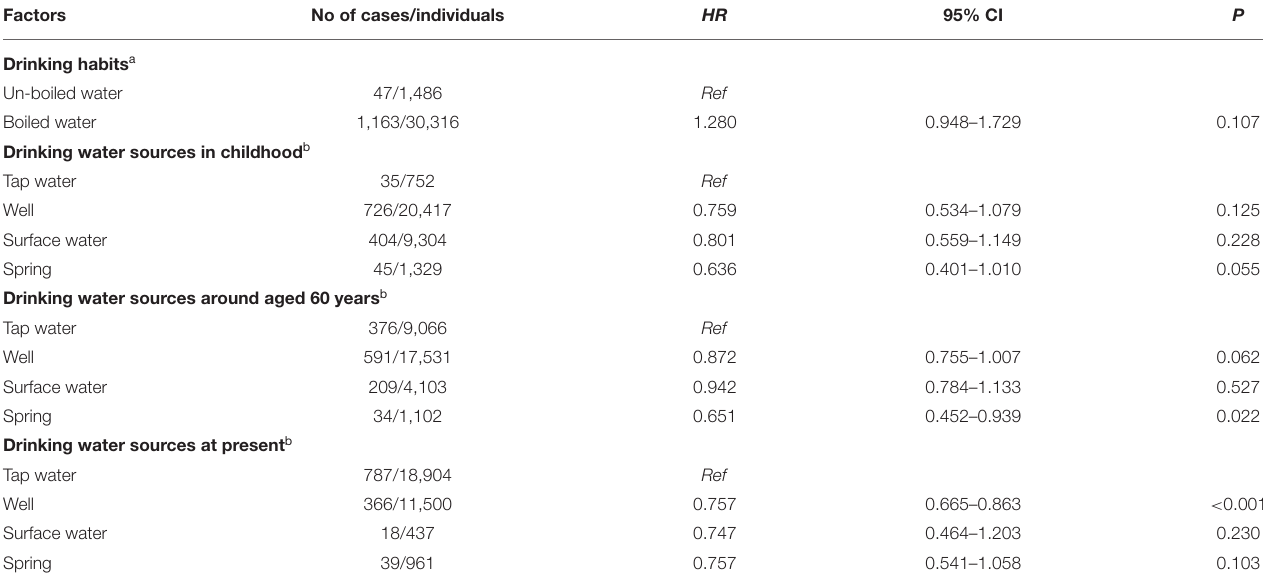
TABLE 3 | The associations of lifespan drinking water sources and habits with CVD mortality ( N = 31,802).